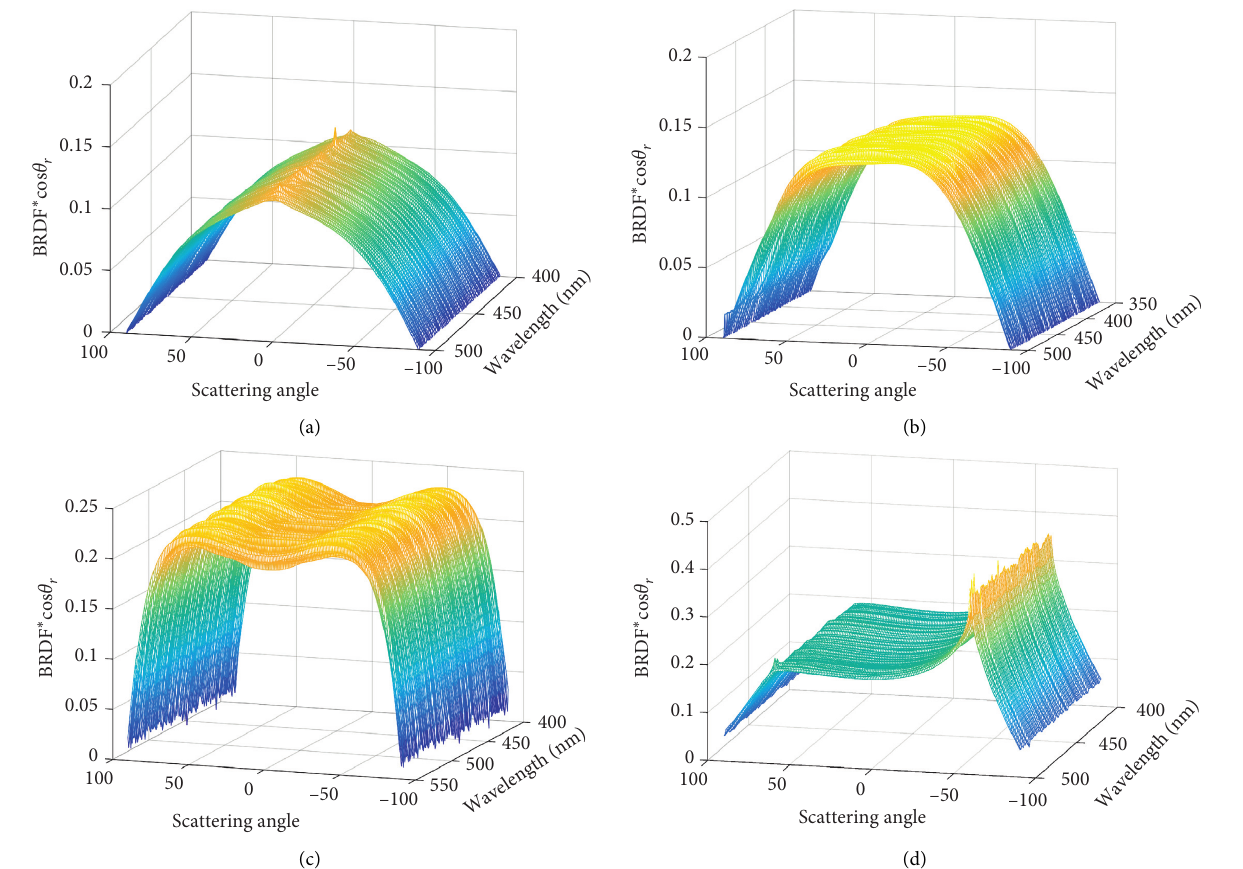
Figure 10: Fitted 3D graph of sample 2. (a) Fitted 3D graph of the 0 ° incident angle; (b) fitted 3D graph of the 30 ° incident angle; (c) fitted 3D graph of the 45 ° incident angle; (d) fitted 3D graph of the 60 ° incident